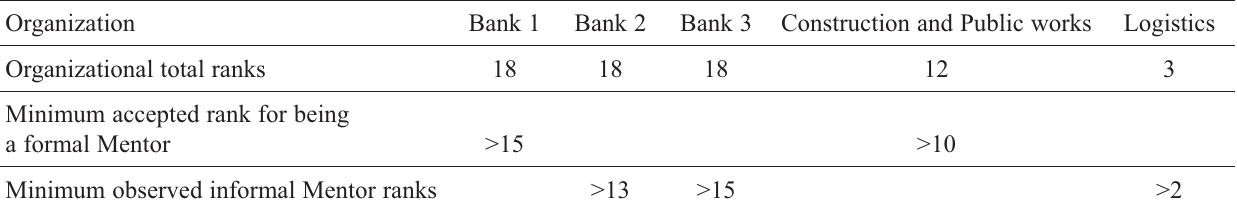
Table 3. Mentors’ career rankings